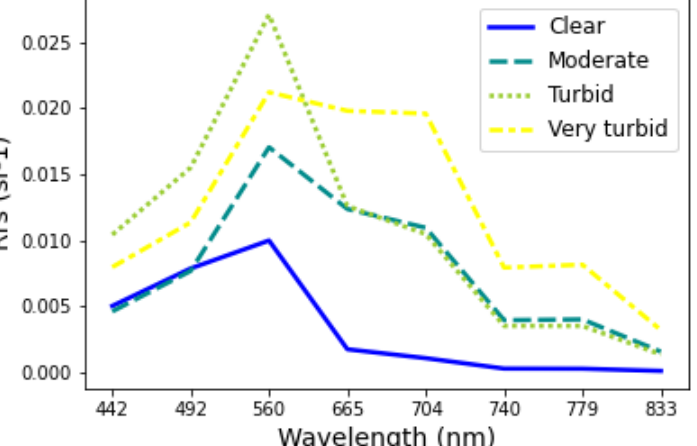
Figure 2. Spectral response of each type of OWT obtained from the average value of all training samples